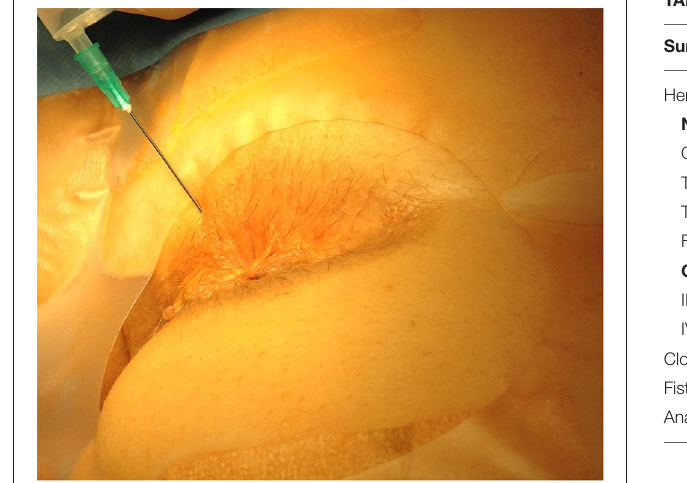
TABLE 2 | Post-operative